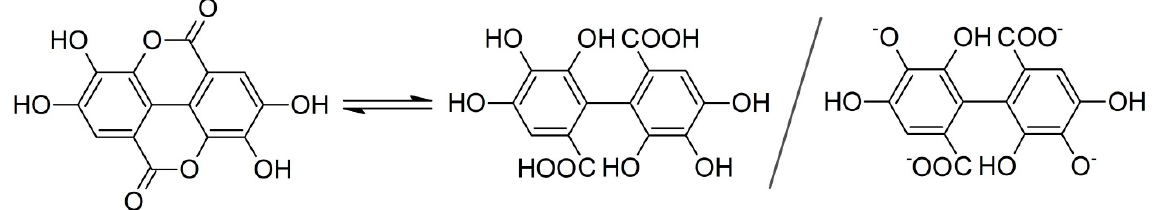
Figure 3. Chemical equilibrium between EA and its opened form, 4,4 ′ ,5,5 ′ ,6,6 ′ -hexahydroxydiphenic acid, and its potential intercalated form.